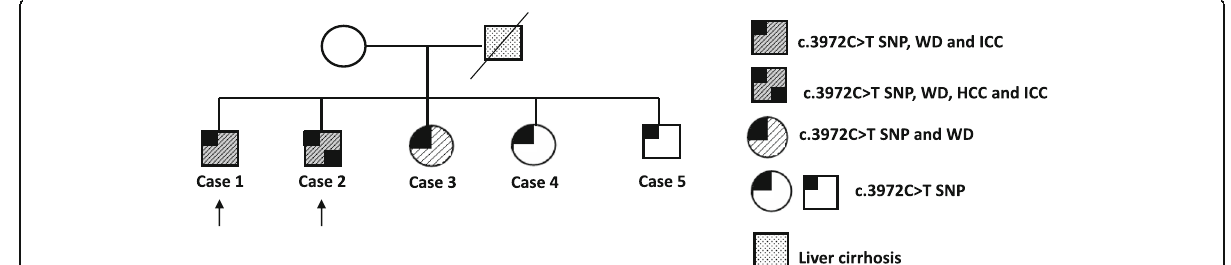
Fig. 2 Family pedigree. Type of diseases are shown in the legend. Black arrows show the two brothers with concomitant c.3972C> T SNP at exon 28 of ABCC2 gene, Wilson disease and primary liver malignancies. SNP: single nucleotide polymorphism; WD: Wilson disease; HCC: hepatocellular carcinoma; iCCA: intrahepatic